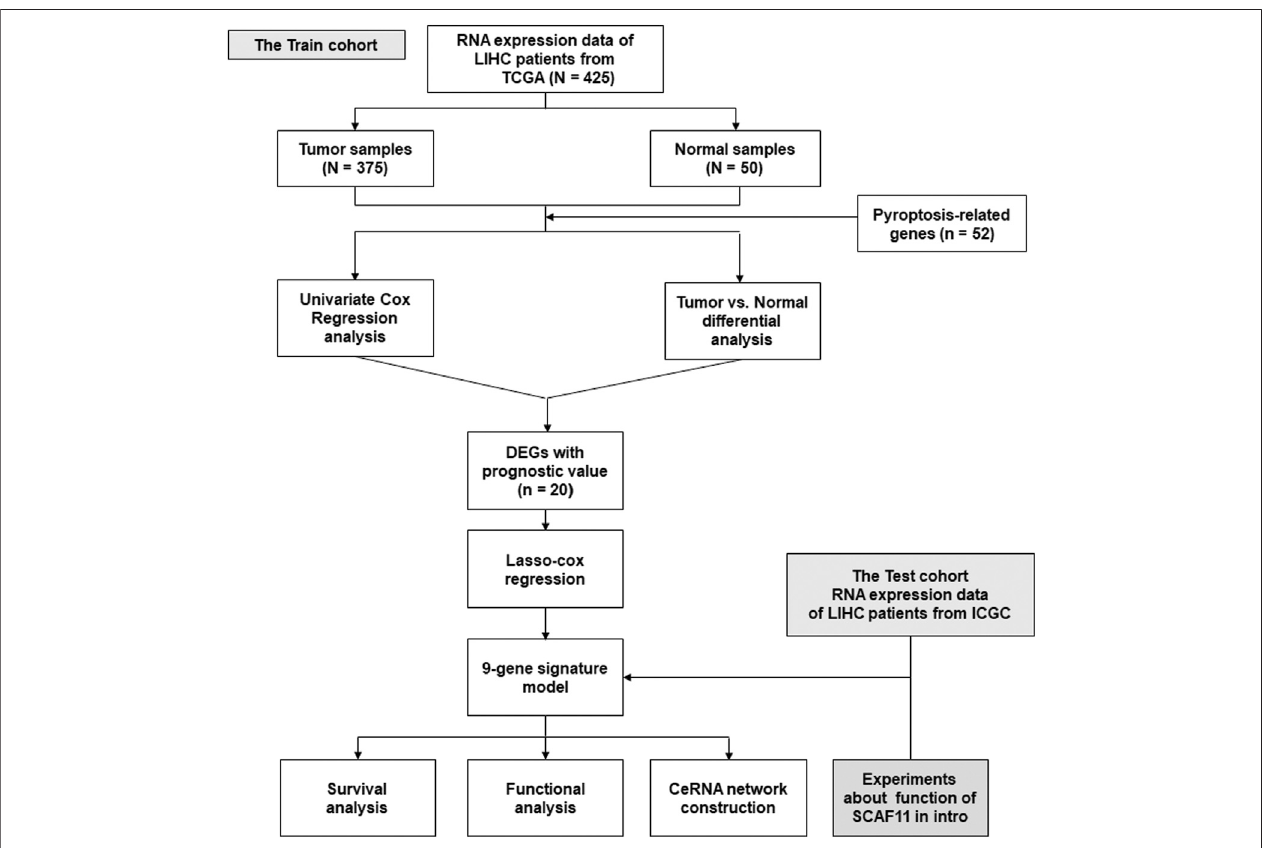
FIGURE 1 | Flowchart of bioinformatics